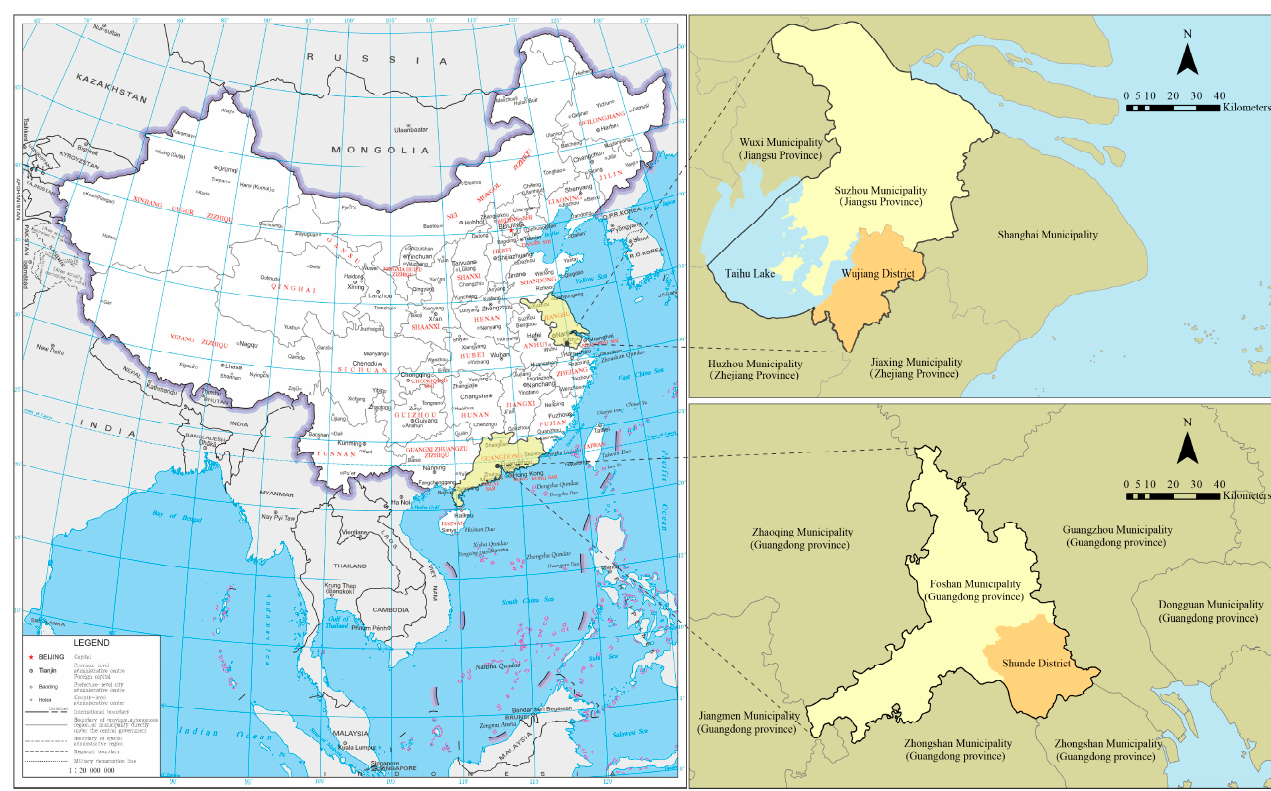
Figure 3. Location of Shunde in Guangdong province and Wujiang in Jiangsu province.